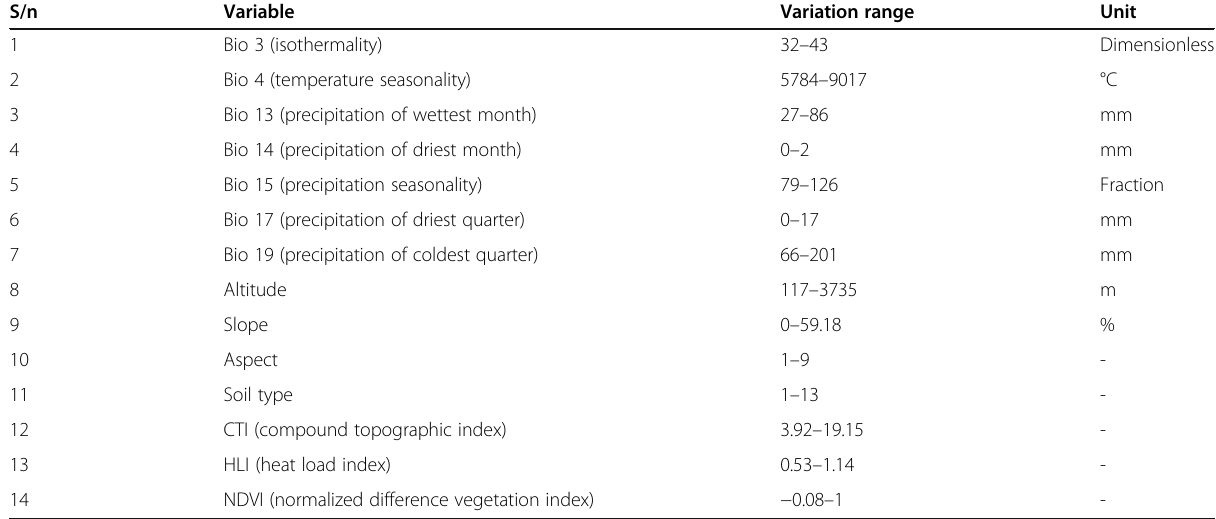
Table 1 Details of environmental variables used in habitat suitability modeling of Amygdalus scoparia in Fars Province, southern Iran